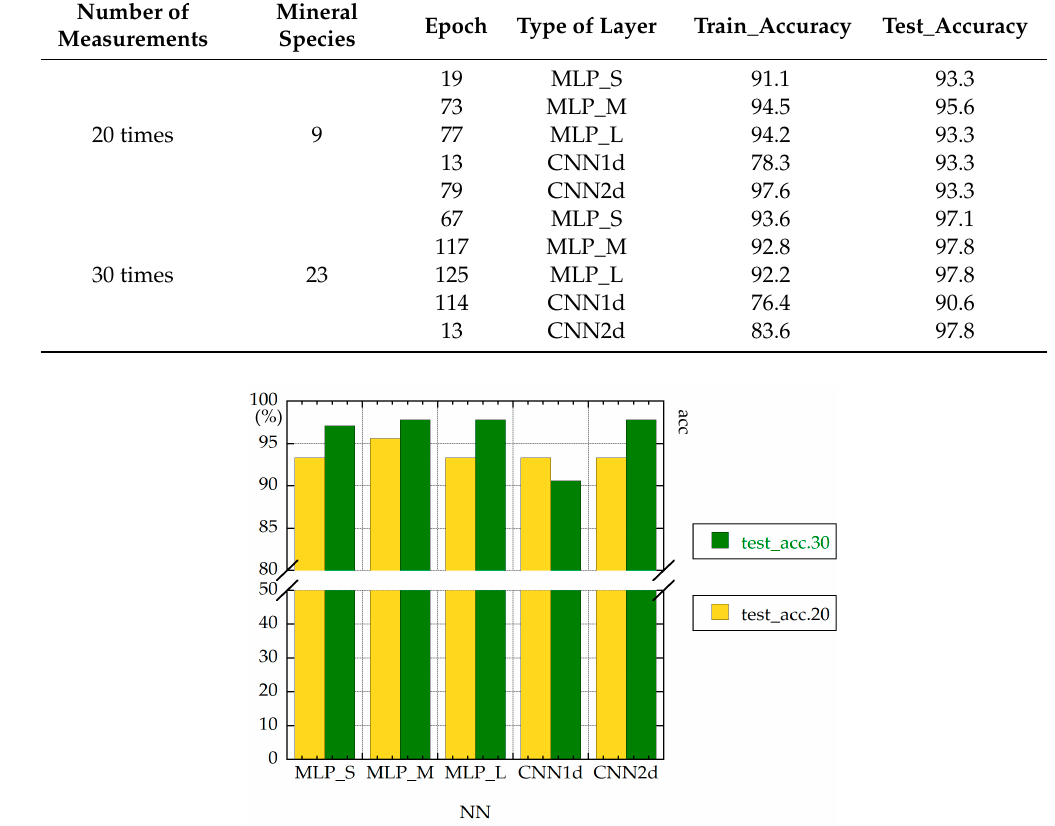
Table 5. Accuracy of each neural network (NN) (best test_acc value).